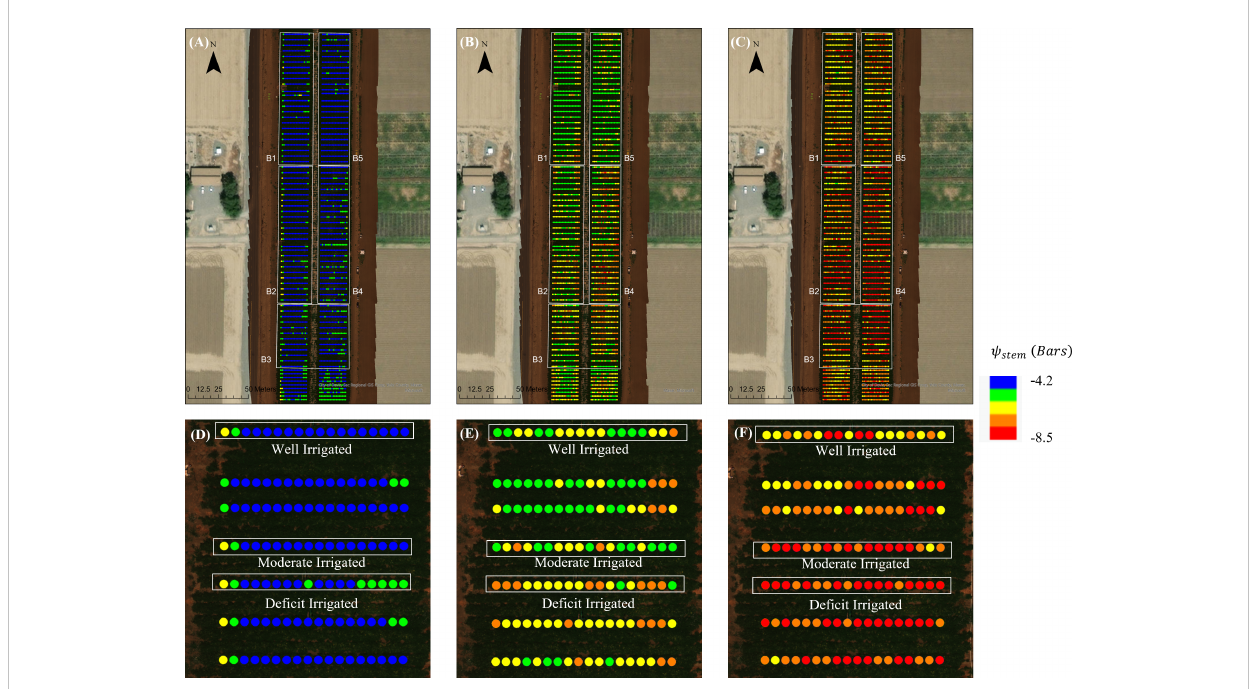
FIGURE 12 Maps of the plant-level predicted stem water potential ( y stem ) from the unmanned aerial vehicle-based random forest model for the tomato fi elds during three dates: (A) June 26, (B) Aug 1, and (C) Aug 14. Also shown is the detailed plant-level predicted y stem of a sample region in block 2 for the three dates: (D) June 26, (E) Aug 1, and (F) Aug 14.